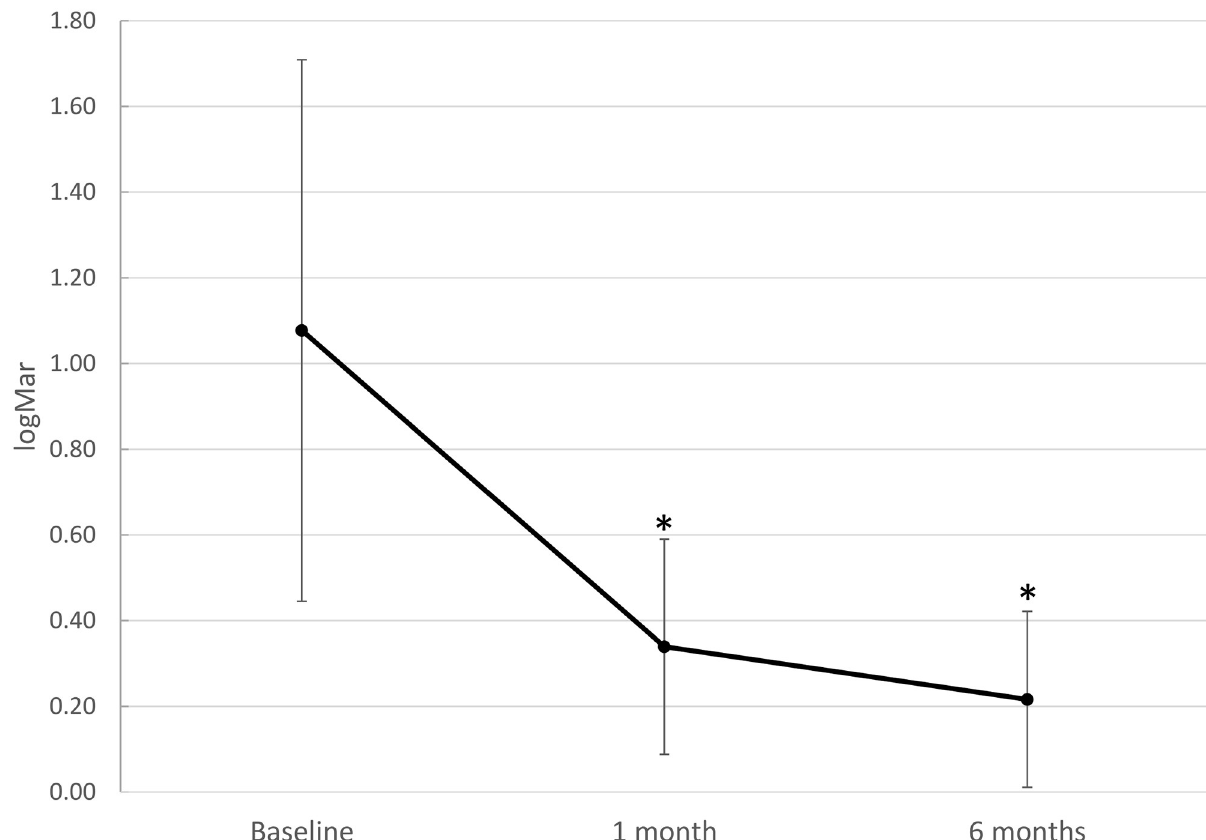
Fig 4. Visual acuity recovery. Visual acuity (VA) indicating progressive visual recovery from baseline before vitrectomy for re-attachment of macula- involving primary rhegmatogenous retinal detachment with vitrectomy and gas. Baseline VA (LogMAR) improved after 1 and 2 months. Whiskers indicate standard deviations and asterisks ( � ) indicate significant differences compared to baseline (p < 0.001; n = 74 for all three time points).